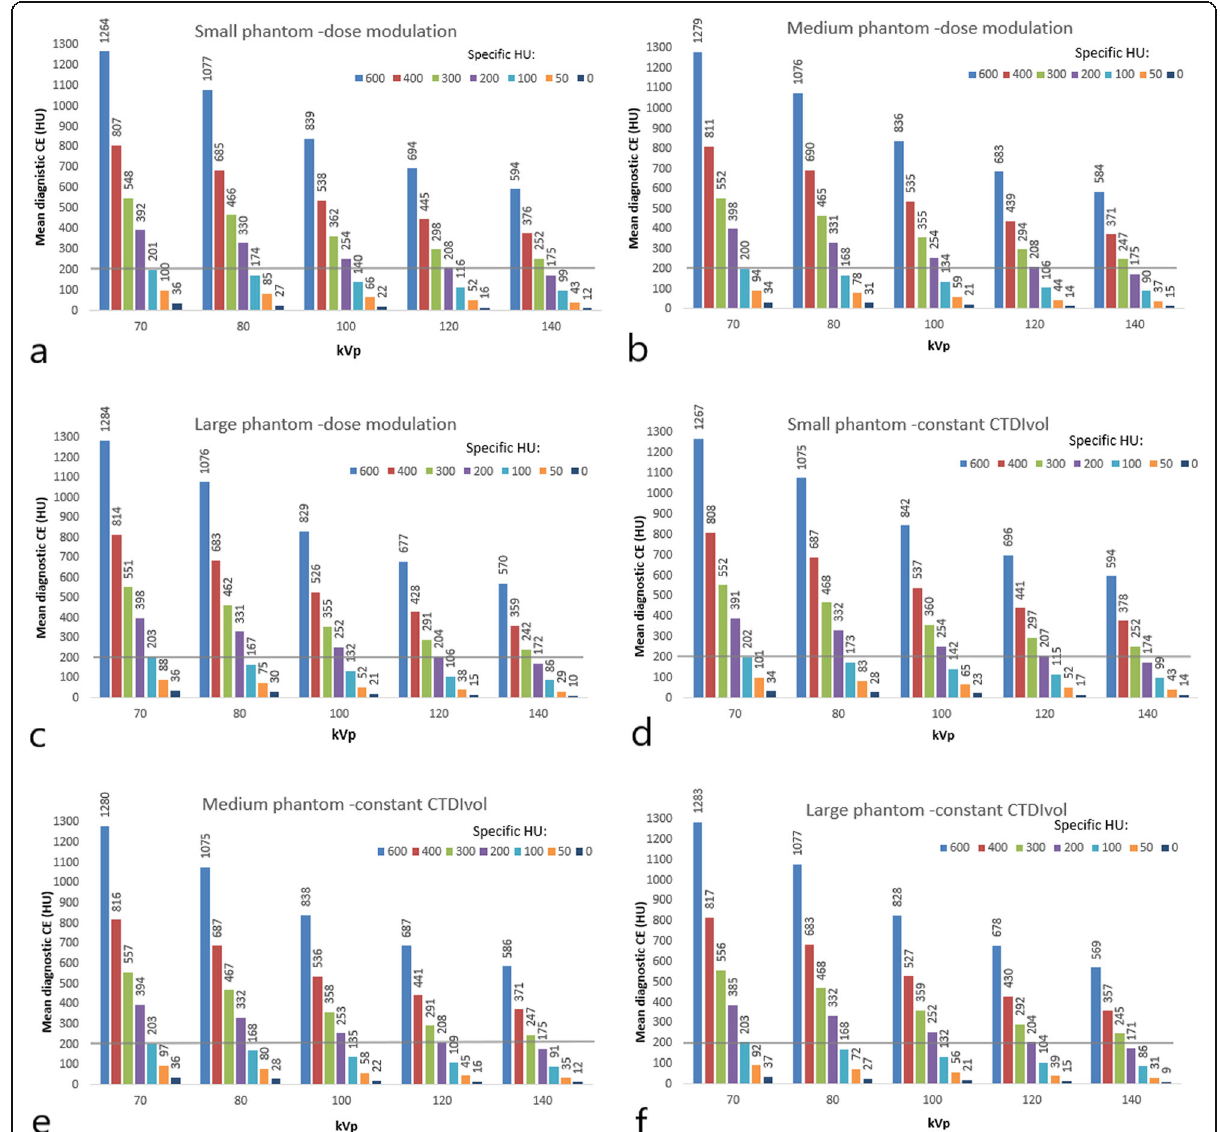
Fig. 2 Measured contrast enhancement (CE) values as a result of employed specific HU values between 0 and 600 HU at 70 – 140 kVp when using dose modulation ( a , b and c ) and constant volume computed tomography dose index (CTDIvol) ( d , e and f ) for the three different phantom sizes. The horizontal line displays the reference diagnostic enhancement level of ≥ 200